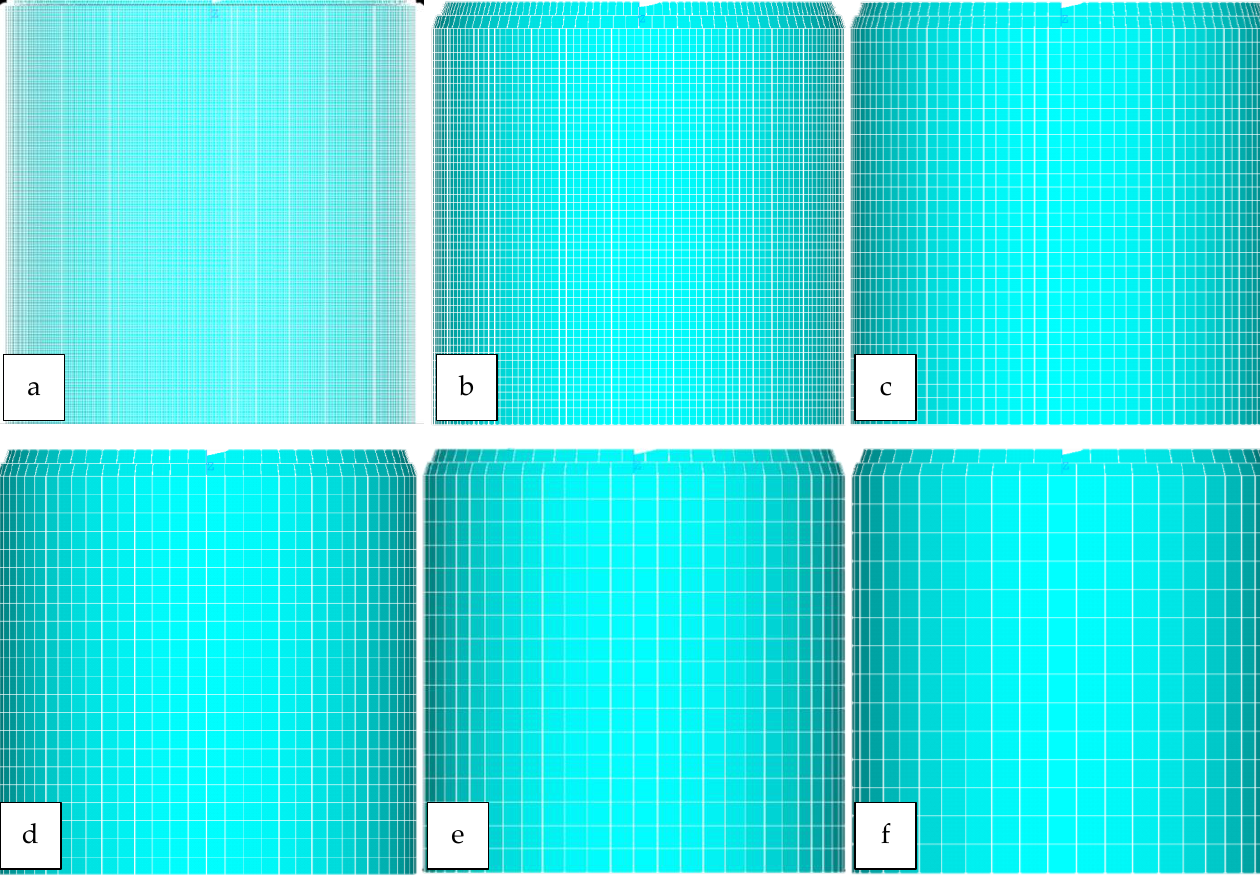
Figure 6. Mesh sensitivity models. ( a ) 0.5, ( b ) 1.5, ( c ) 2.5, ( d ) 3.5, ( e ) 4.5, ( f ) 5.5 mm [66].